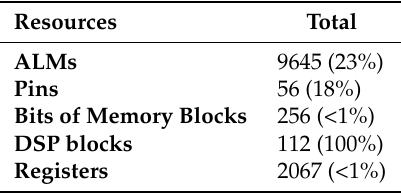
Table 7. Hardware Resourcers used by the entire implementation.